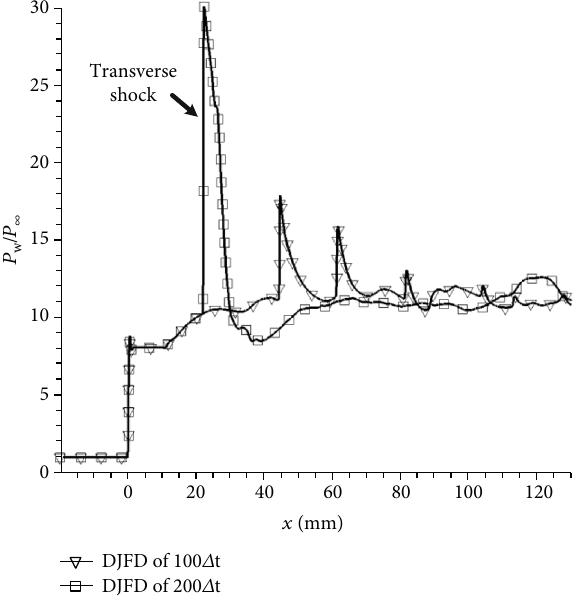
Figure 6: Pressure distributions on the bottom boundary of the steady fl ow fi elds after the DJFD of 100 Δ t and 200 Δ t at θ = 32 ∘ .